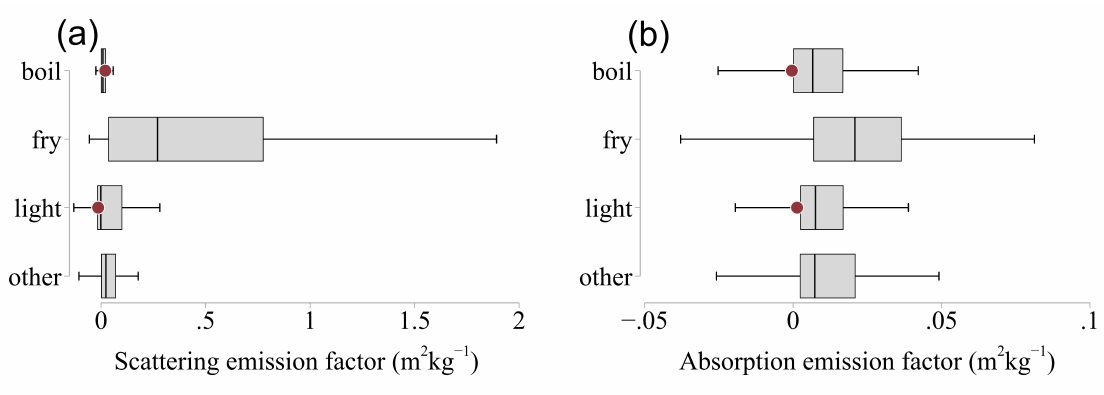
Figure 5. Biogas cooking missions of scattering particles ( a ) and absorbing particles ( b ). The red dot indicates the laboratory measurements of biogas